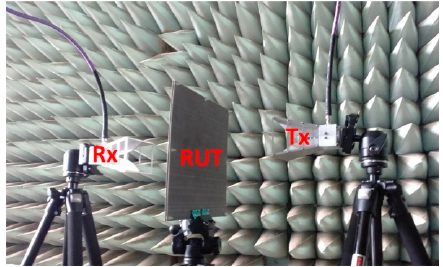
Figure 13. Measurement system setup for the FSS in the near field region.